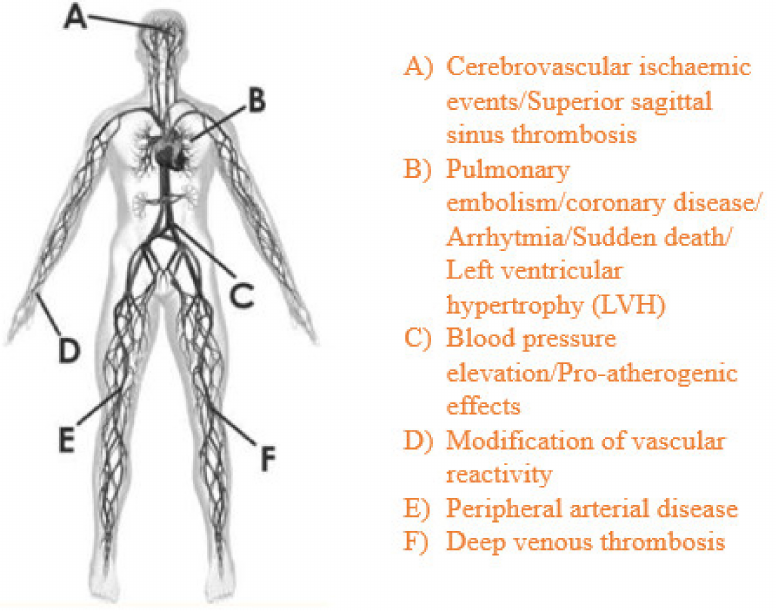
Figure 2. AAS systemic cardiovascular